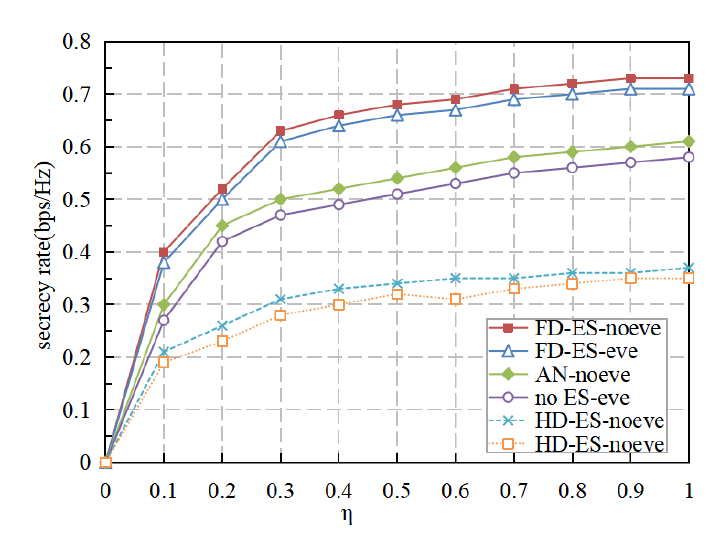
Figure 6. Secrecy rate vs. energy harvesting